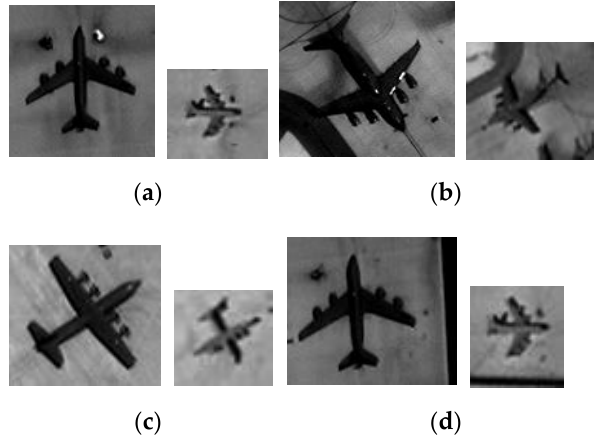
Figure 2. Examples of multiangle and multiresolution airplane slices observed by SuperView-1 and Jilin-1 satellites in dataset 2. ( a – d ) Display the paired multiangle multiresolution airplanes obtained from SuperView-1 satellites (the left one) and Jilin-1 satellites (the right